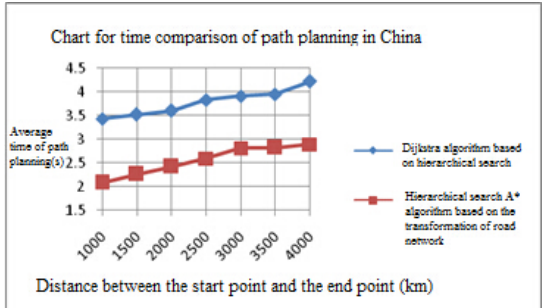
Fig. 5 Chart for time comparison of path planning in China by using two